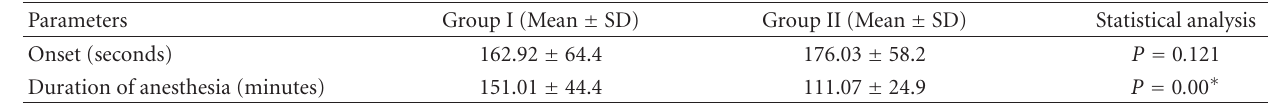
Table 2: Onset and duration of anesthesia.